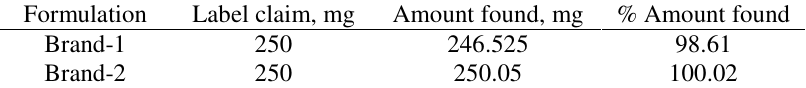
Table 2. Assay of levetiracetam.